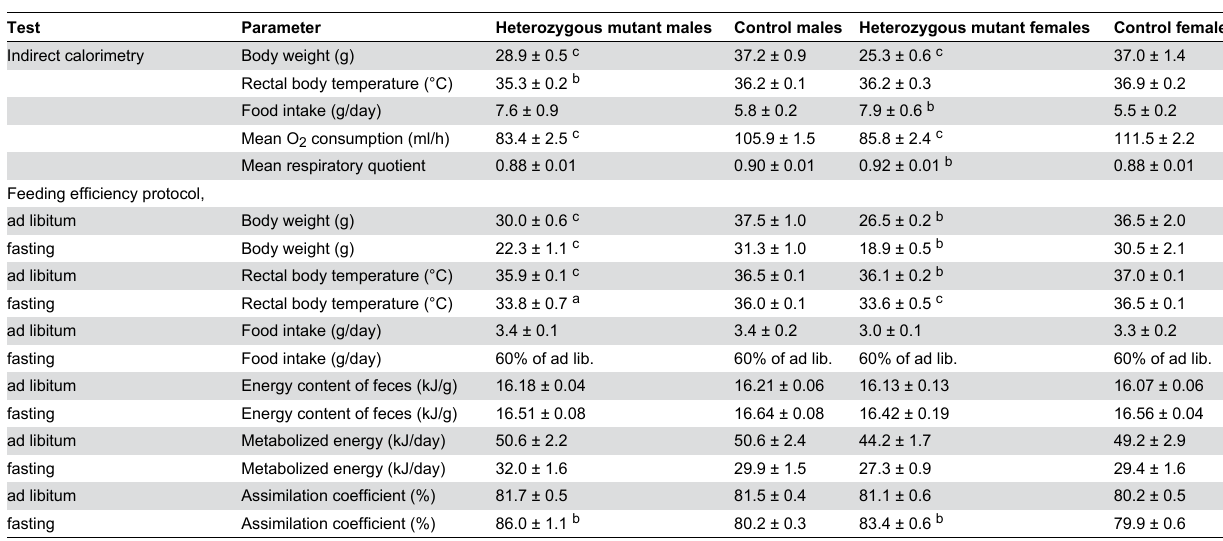
Table 3. Analysis of energy metabolism in line Umod C93F .